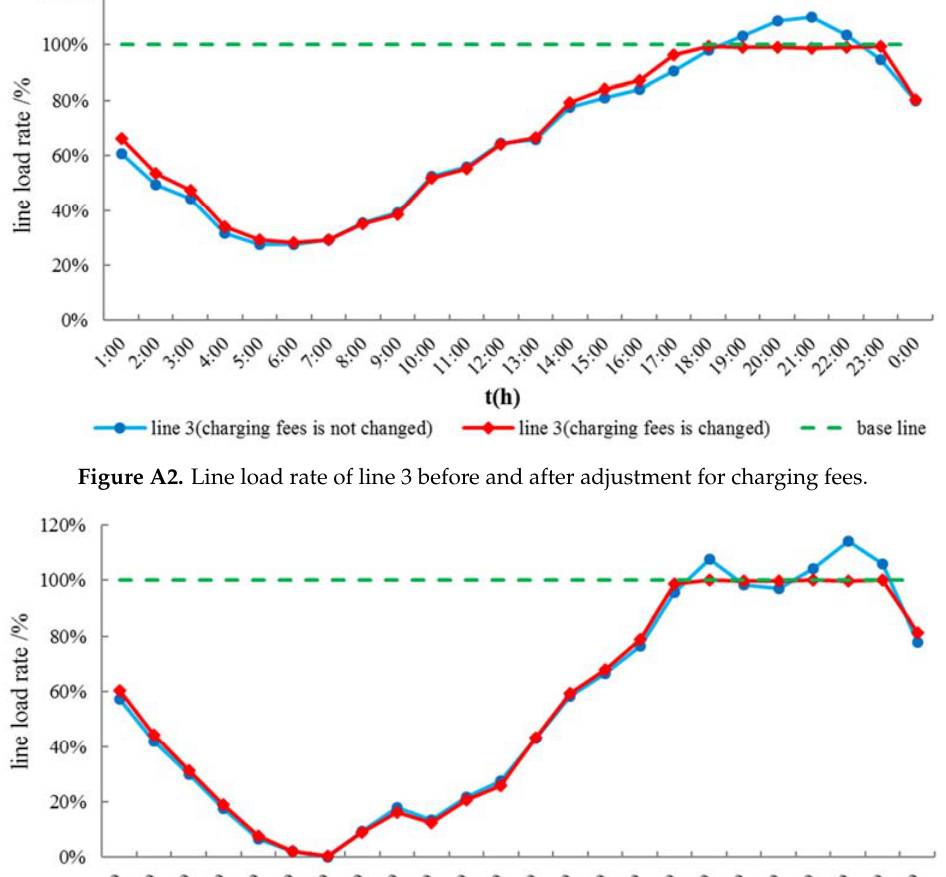
Figure A4. Line load rate of line 5 before and after adjustment for charging fees. Figure A5. Line load rate of line 25 before and after adjustment for charging fees.